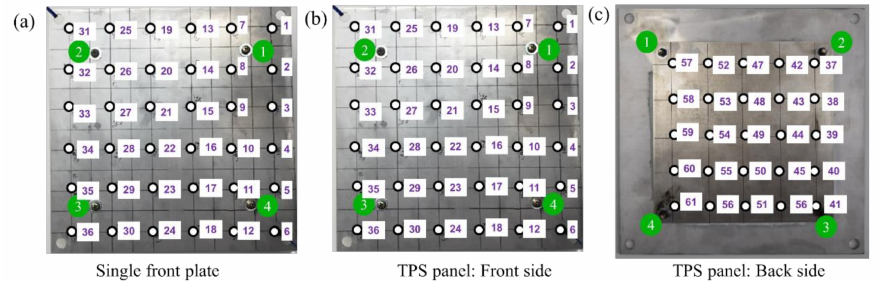
Figure 6. Schematic of test structure and numbering system: ( a ) load-carrying plate with numbering system of 36 marked points, the metallic TPS panel: ( b ) front load-carrying plate and ( c ) back structure (titanium) with numbering system of 61 marked